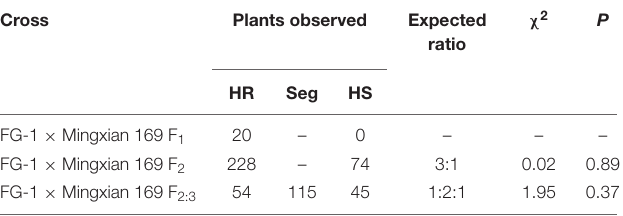
Table values of χ 2 for significance at P = 0.05 are 3.84 (1 df), 5.99 (2 df).